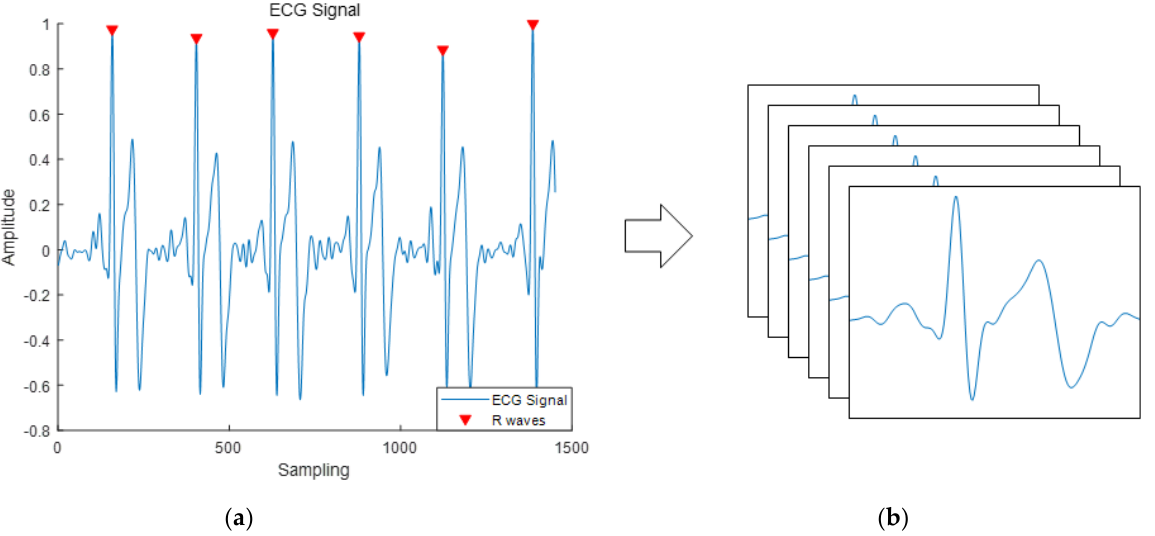
Figure 17. Detected R-peak and signal divided into one cycle. ( a ) Detected R-peak; ( b ) one cycle